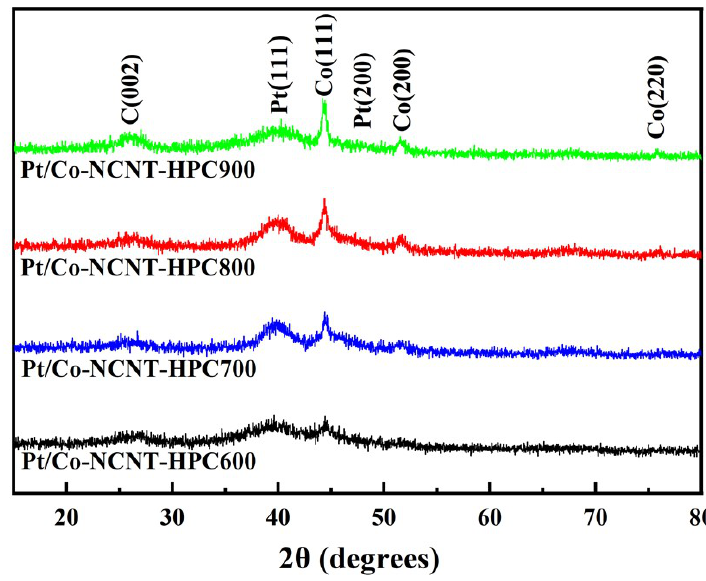
Figure 5. XRD patterns of Pt/Co-NCNT-HPC catalysts.